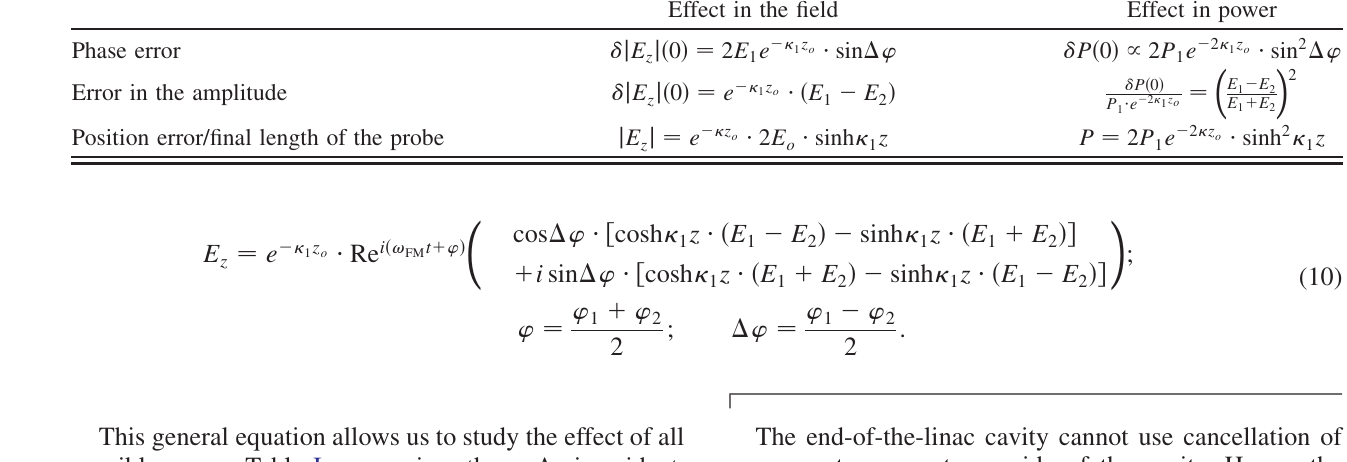
TABLE I. Effect of errors on canceling evanescent waves. Effect in the field Effect in